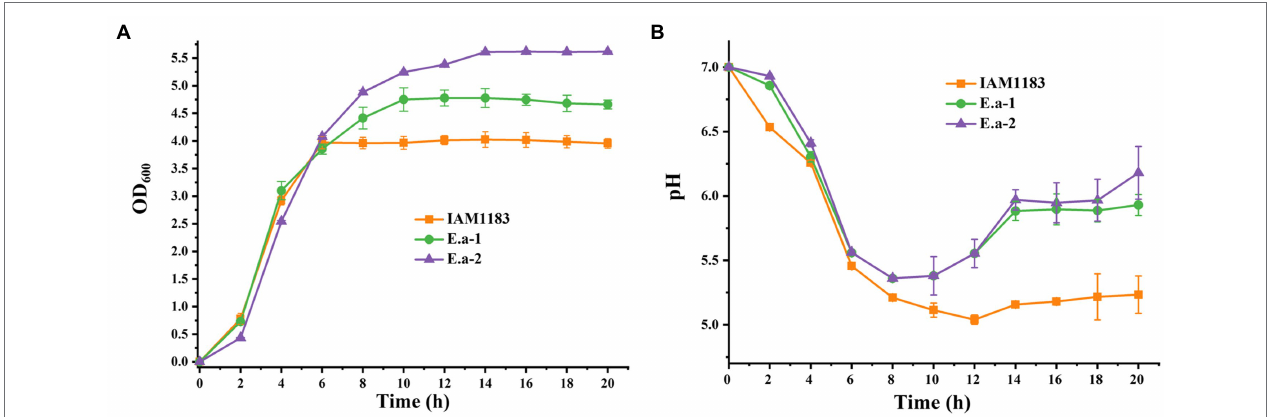
TABLE 2 | Comparison of wild-type Enterobacter aerogenes IAM1183 and the mutants Ea-1 to -4 in 20-h shake-flask fermentations using 40 g/L of glucose as the carbon source ( n = 3). End products